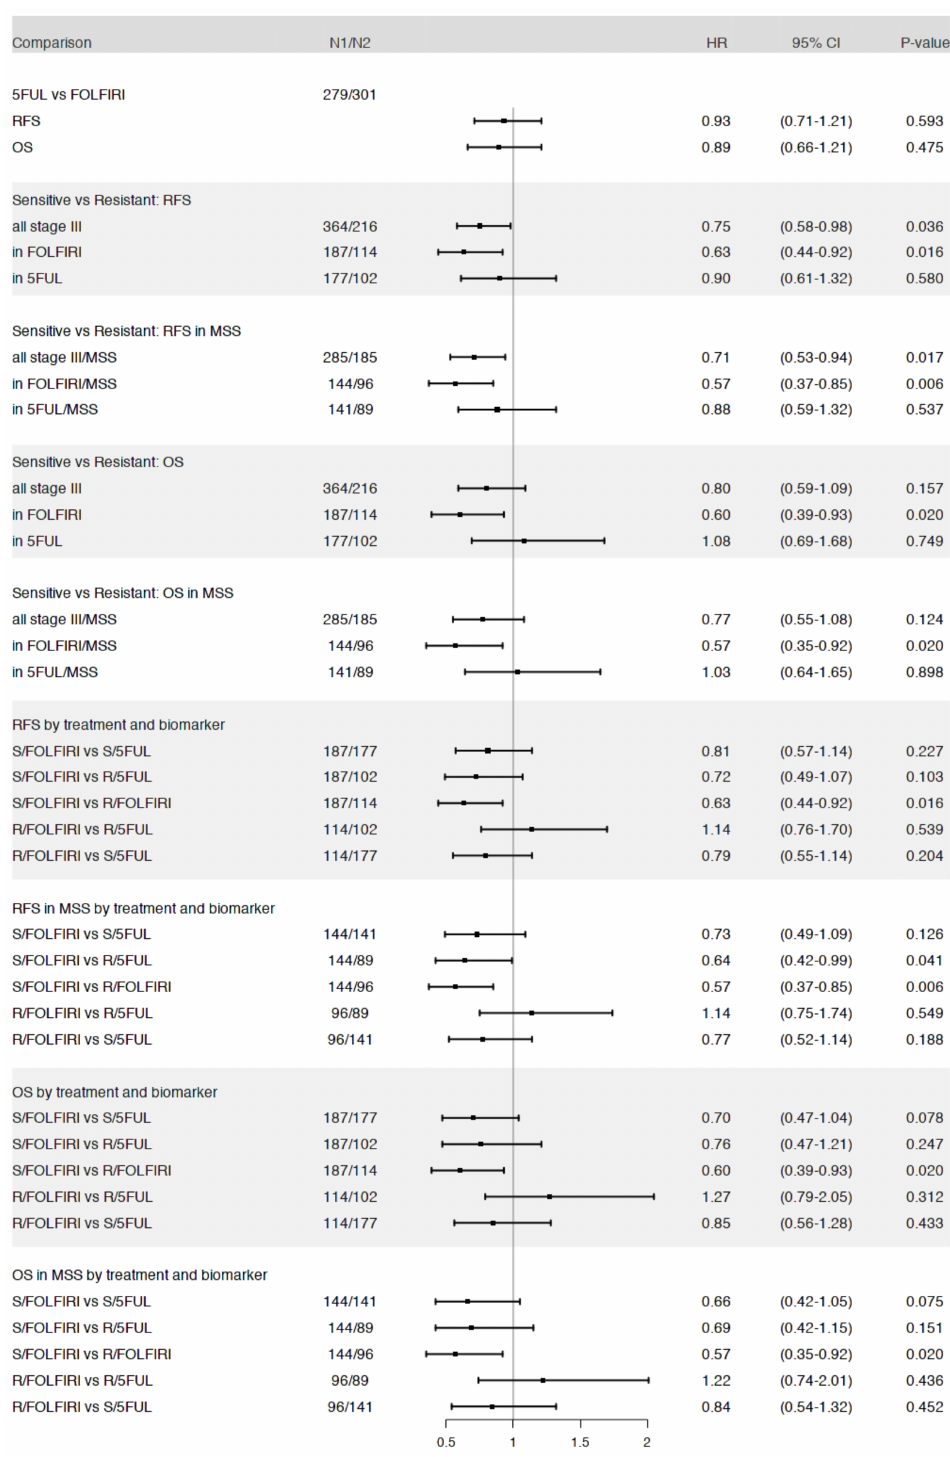
Figure 1. Summary of main survival analysis results: log-rank tests were used to assess the statistical significance of survival di ff erences between groups of interest. Each section of results refers to a set of related tests. The di ff erences assessed are given in the first column, the corresponding sample sizes in the second column (N1 / N2: sample size of the first and second group, respectively), while the columns 3–6 summarize the test results in terms of hazard ratios and 95% confidence intervals (plots in column 3) and corresponding p -values (log-rank test—column 6). In the first column, “sensitive” was abbreviated as “S” and “resistant” as “R”, respectively. Thus, “S / FOLFIRI” stands for “sensitive under FOLFIRI treatment”